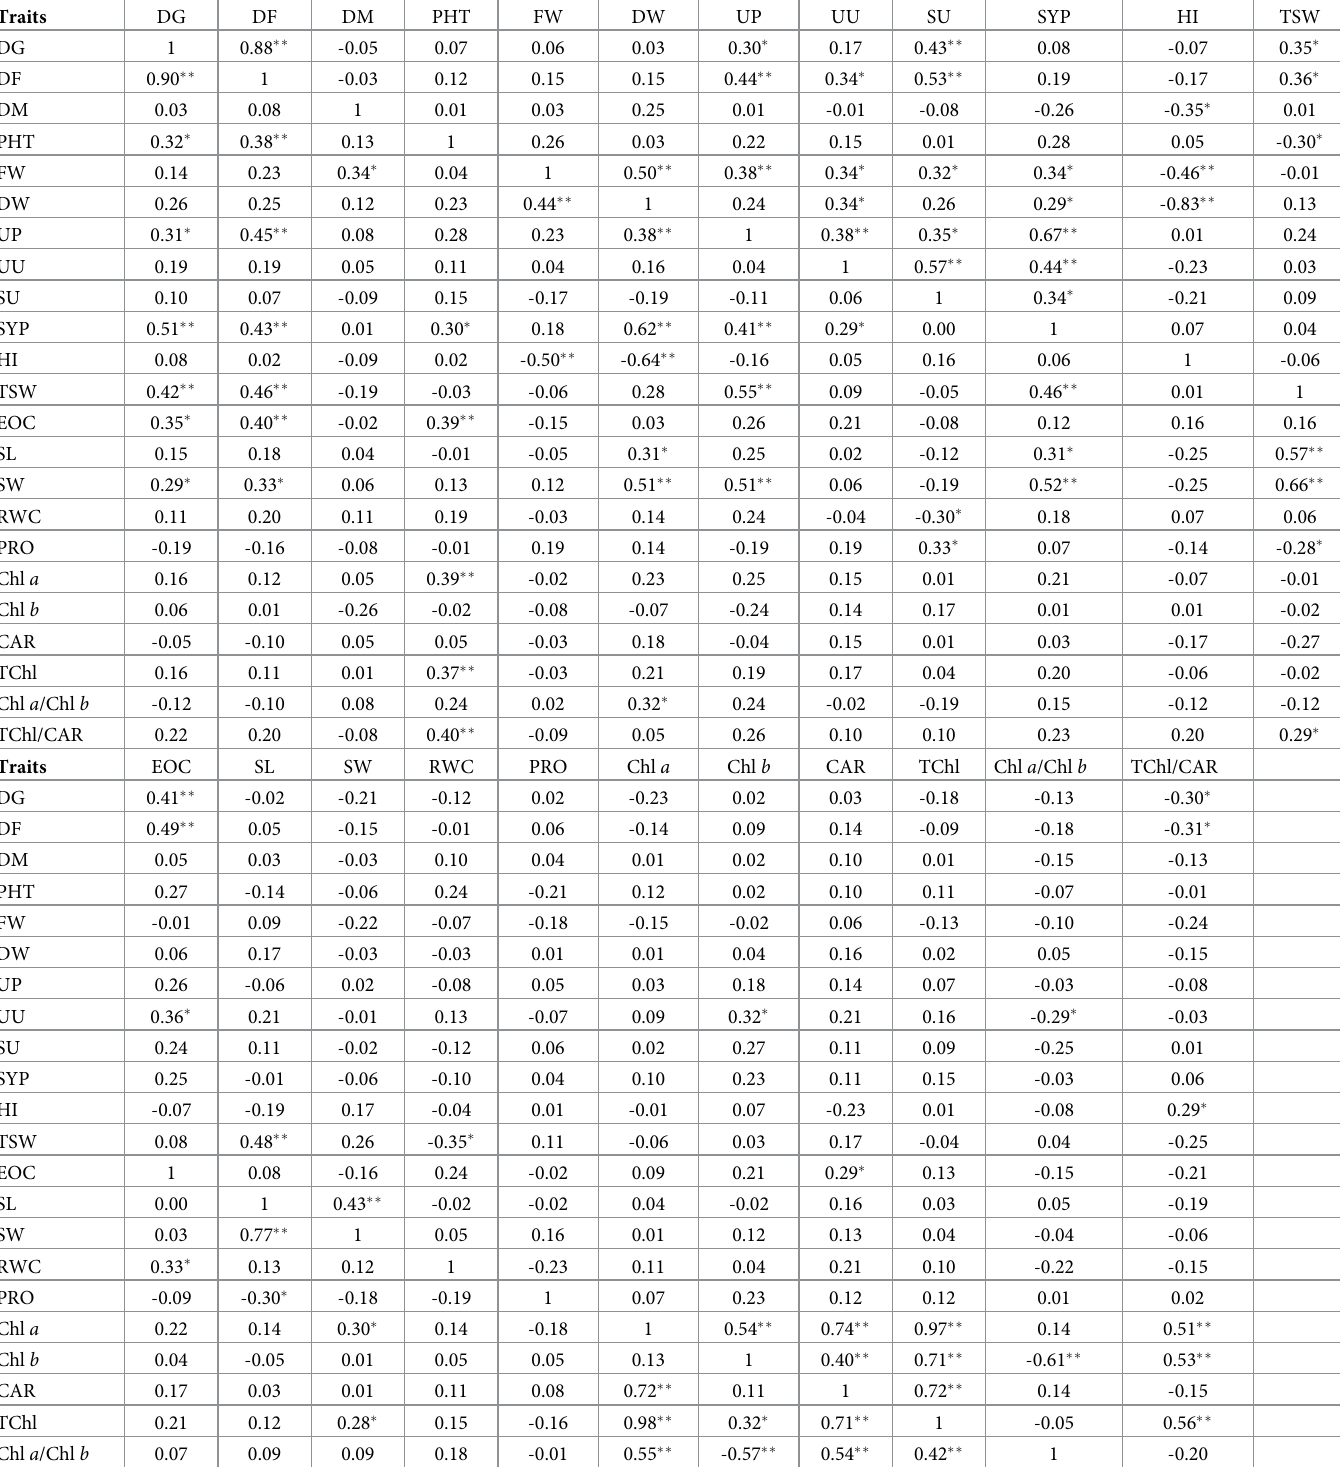
Table 7. Correlation coefficients among morphological, agronomic, and physiological traits of open-pollinated (OP) population of fennel in normal (above diago- nal) and water deficit condition (below diagonal).